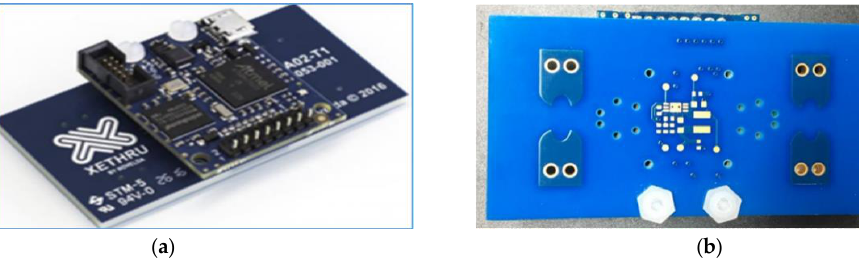
Figure 9. Xethru-X4 radar chip: ( a ) front view and ( b ) back view. Table 1. Specifications of a single IR-UWB radar chip.